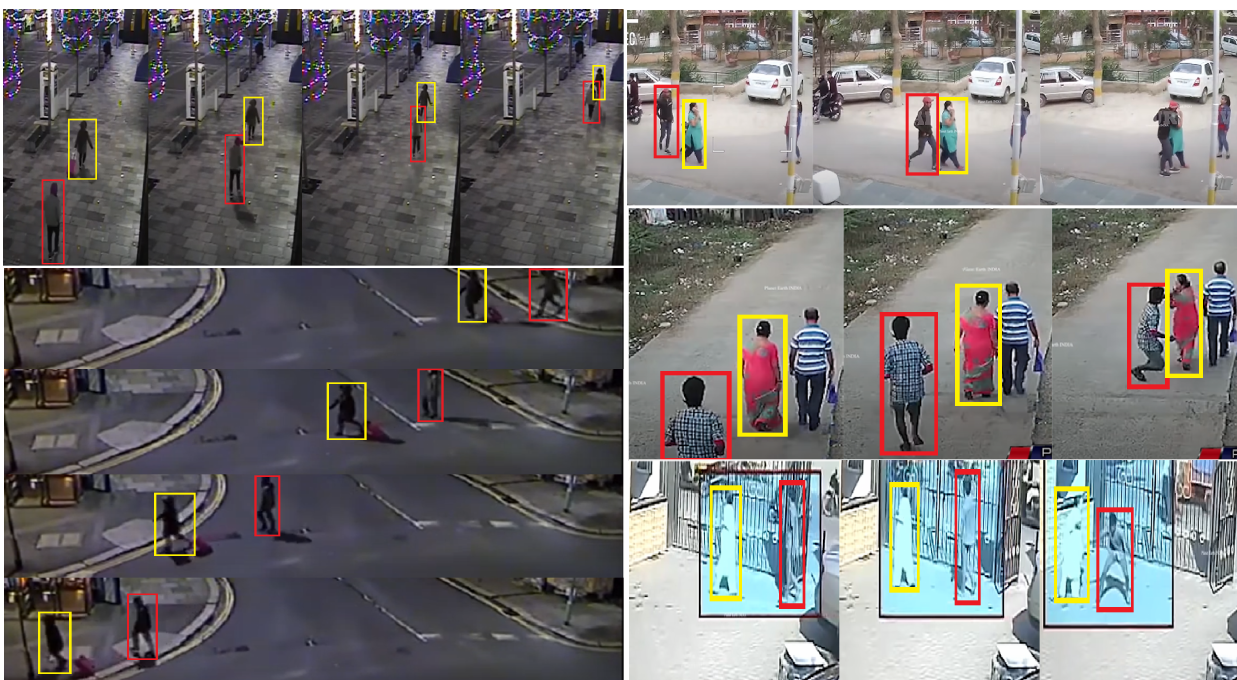
Figure 1. Real world example of tailing, in the streets of London (source-YouTube). On left : Two examples of tailing, in both cases the tailing person was yielding a knife while tailing (London). On Right : Three examples of tailing, followed by snatching (India). Suspect in red rectangle, while victim in yellow